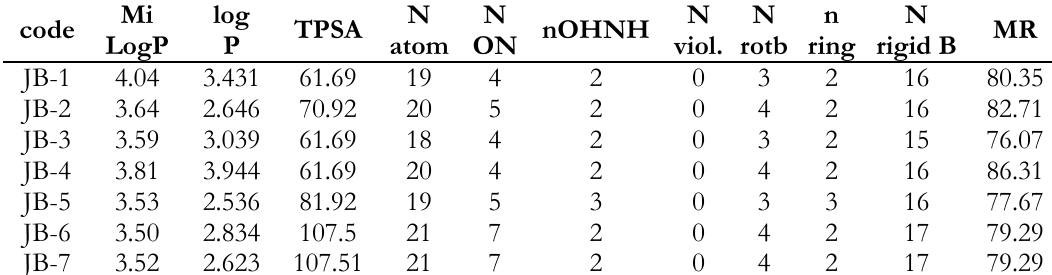
Table II. Drug likeness score of Azomethines code